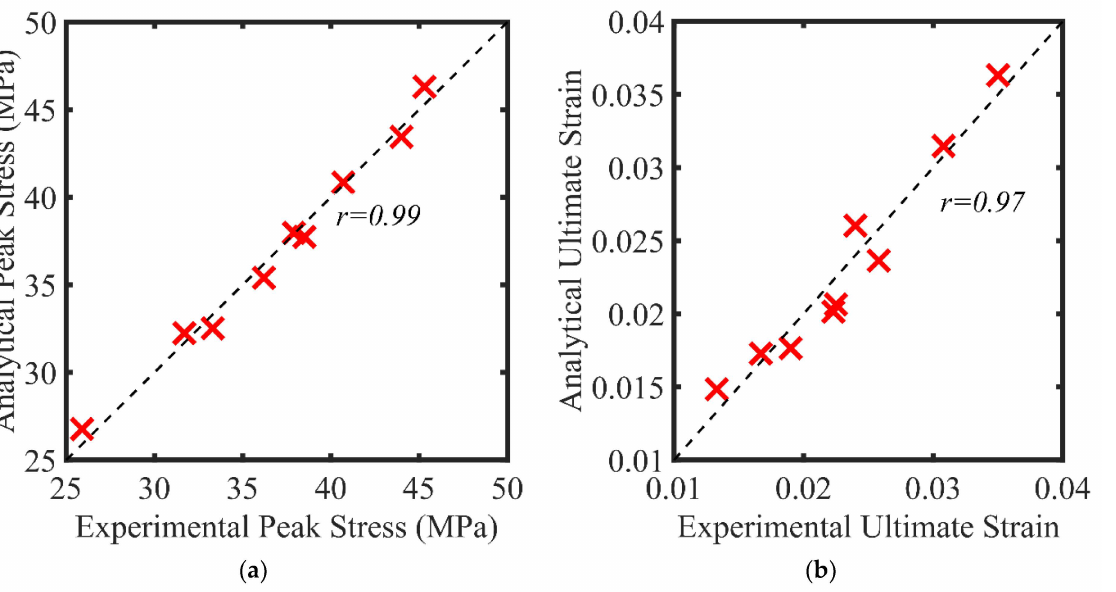
Figure 13. Comparison of experimental versus predicted ( a ) peak compressive stress and ( b ) ulti- mate strain. Table 6. Assessment of analytical models to predict ultimate strain of FCSM confined